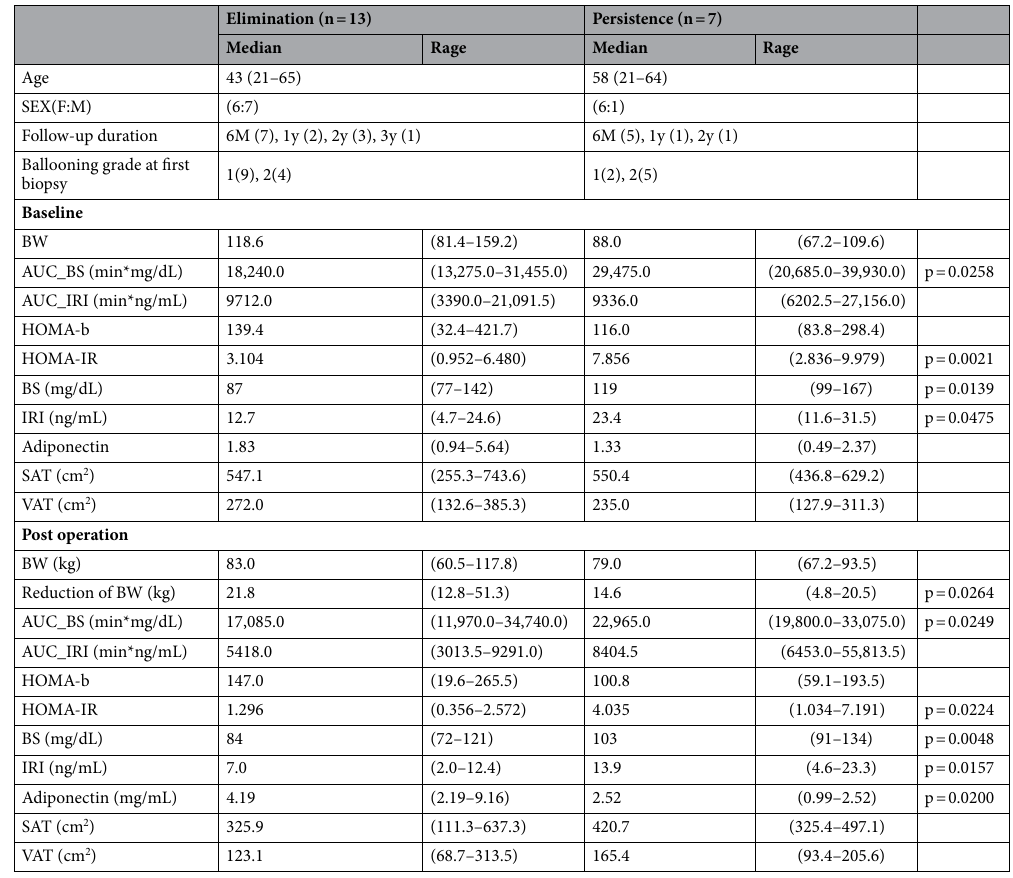
Table 4. Comparison of anthropometric and glucose metabolic markers between the balloon elimination and persistence groups. BW body weight; AUC area under curve; BS blood sugar; IRI serum insulin;